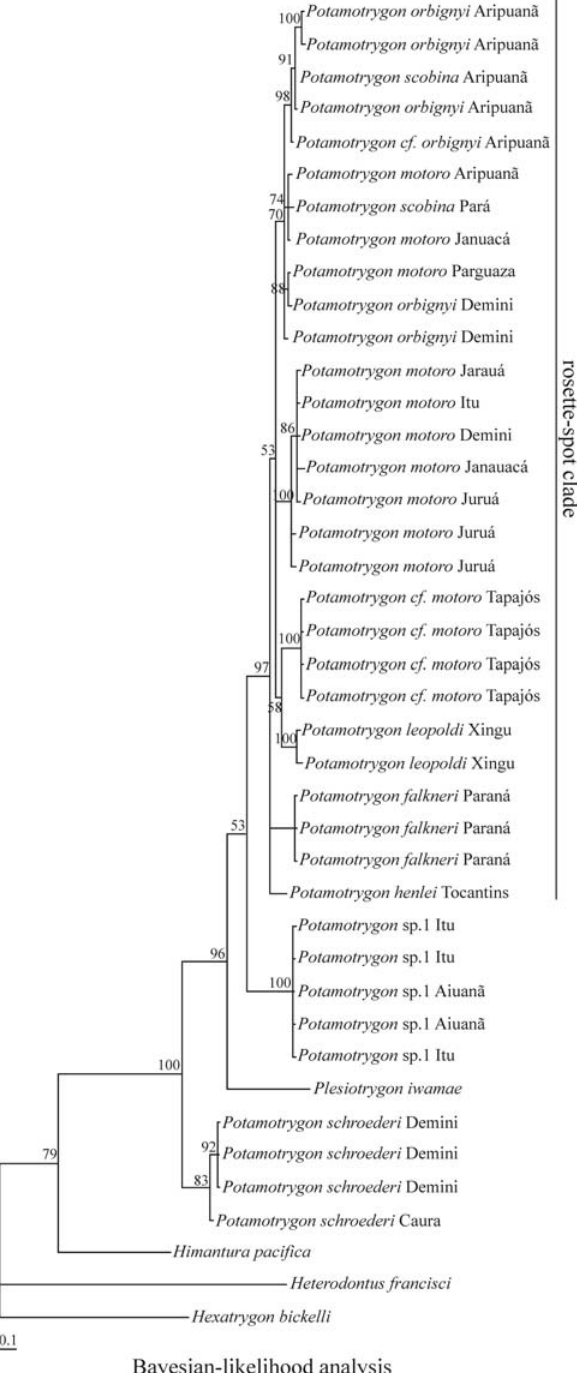
Figure 3 - Phylogenetic relationships of the potamotrygonids based on a Bayesian-inferencephylogeneticanalysesofmitochondrialCOIsequence data using GTR + inv substitution model. Plesiotrygon iwamae appears nested within Potamotrygon with Potamotrygon schroederi as sister spe- cies of the family. P. motoro , P. scobina , and P. orbignyi are non-mono- phyletic. The relationships among species of rosette-spot group are not well supported and branch lengths are short, evidence of a